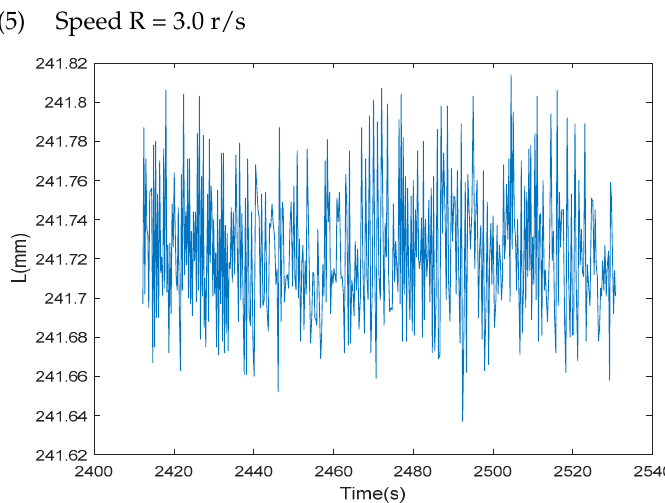
Figure 14. Measurement results of the distance between two targets at 2 r/s. (5) Speed R = 3.0 r/s